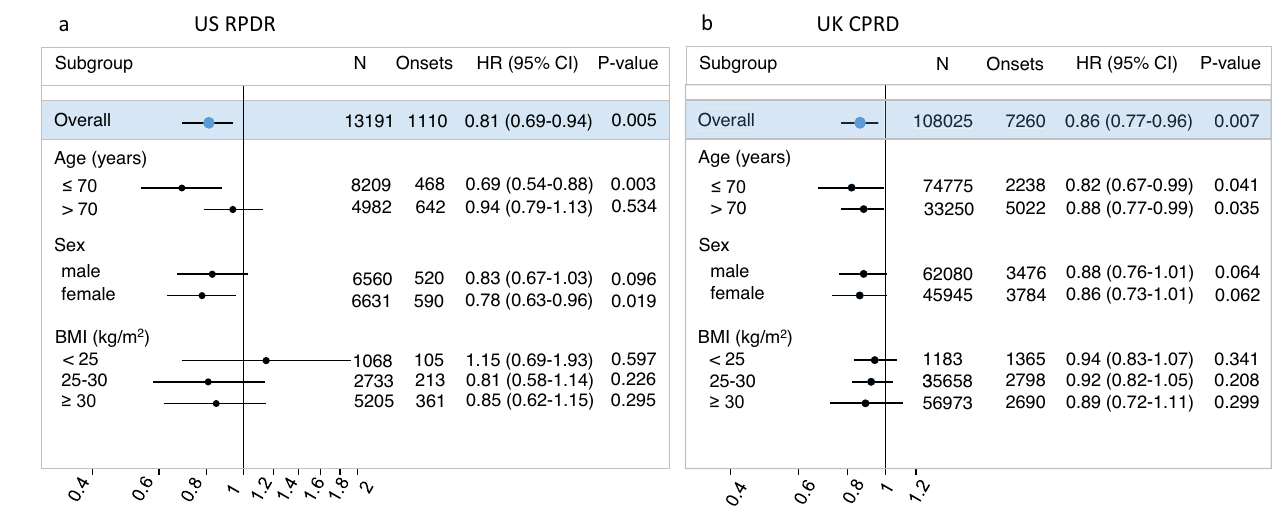
patients at baseline, Onsets=# of patients with dementia onset during follow-up andpriortodeath.CovariatebalancingusingIPTWwasconductedineachstratum independently. Error bars represent 95% CIs for hazard ratios. A two-sided Wald testofwhetherthehazardratioassociatedwithmetformintreatmentinitiationis1, with robust variance estimator, was used. No further correction for multiple hypothesis testing was